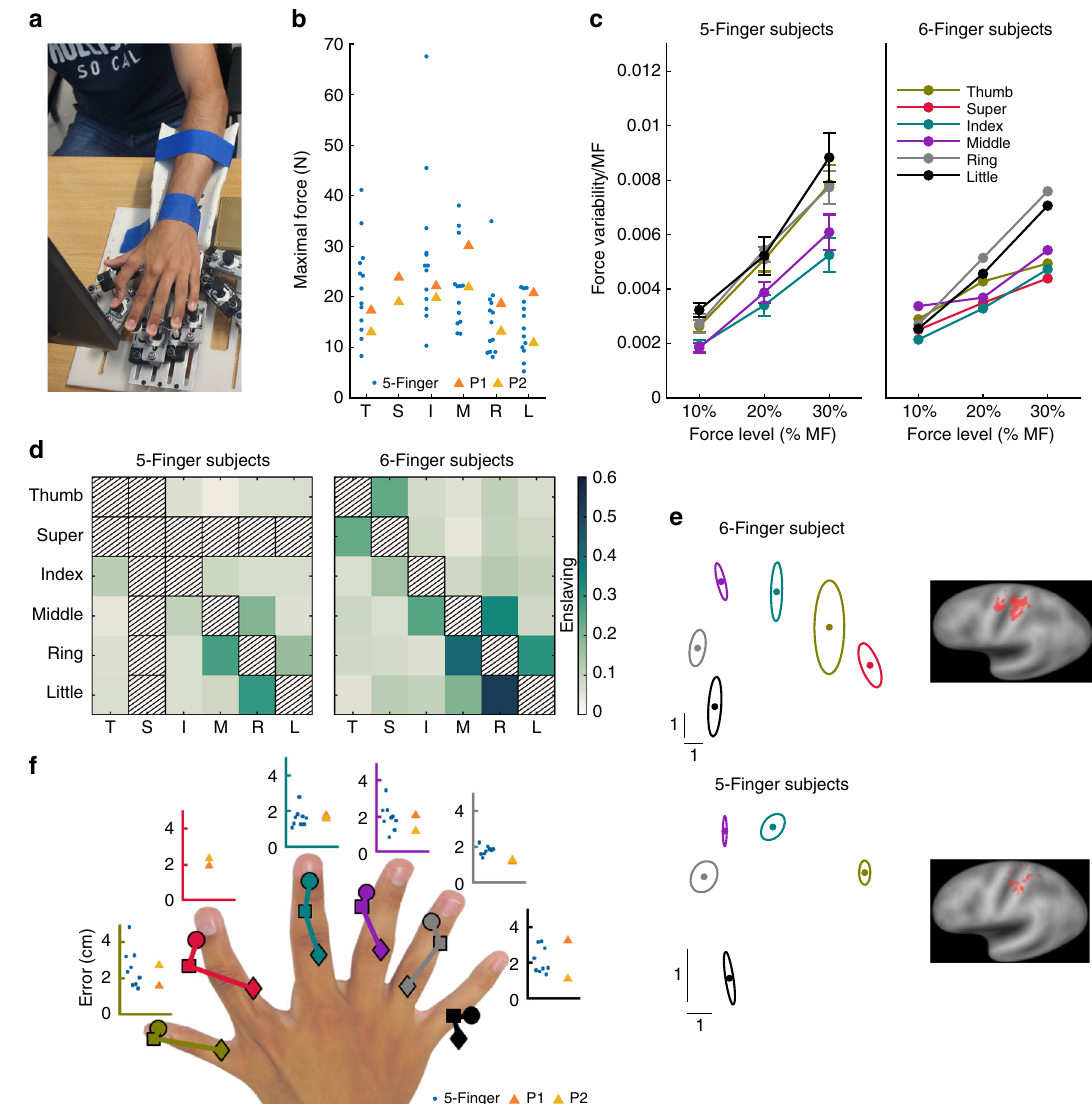
Fig. 2 Neuromechanics of the polydactyly hand. a Dedicated isometric interface to investigate the force capability of each fi nger in individuals with fi ve- and six- fi ngered hands. The interface was used for the analyses presented in subplots ( b – d ). Subjects were initially asked to exert maximal force (MF) with a single fi nger. In a consecutive experiment subjects were asked to control 10%, 20%, or 30% of MF during 15 s long trials. Two six- and 13 fi ve- fi ngered subjects carried out these experiments. b MF produced by individual fi ngers. The MF was similar for fi ve- and six- fi ngered subjects for all regular fi ngers. c Force variability (standard deviation of the force) as a function of the magnitude of the produced force expressed in percentage of the maximal force. Error bars depict SEMs across subjects. d Enslaving shows the forces induced in other fi ngers when the subject is instructed to exert the maximal force in one fi nger. Enslaving between fi nger i and j was computed as e ij ¼ F j i ðÞ , where F j ( i ) is the force produced by fi nger j when fi nger i was instructed to produce MF j maximal force. MF j depicts the maximal force of fi nger j . In the matrix plot the instructed fi nger is shown on the y axis, hence, each row shows the induced force relative to the maximal force of the corresponding fi nger, i.e. e i . e Two-dimensional projection (multidimensional scaling, MDS) of fMRI activation in sensorimotor cortex during individual fi nger movements in subject P1 and the average across nine fi ve- fi ngered control subjects (left). Colors depict different fi ngers as in ( c ). Ellipses show the standard error of the mean. The location of the activation cluster of the supernumerary fi nger is separate from the activation clusters of the other fi ngers. Selected voxels which were used for the MDS are shown on the right. f Mental representation of six- fi ngered hands. Blindfolded subjects pointed with the index fi nger of one hand to a cued location ( fi rst, second knuckle or tip) on the other hand. Pointing errors were similar in the two six- and 9 fi ve- fi ngered subjects and similar for the supernumerary as for other fi